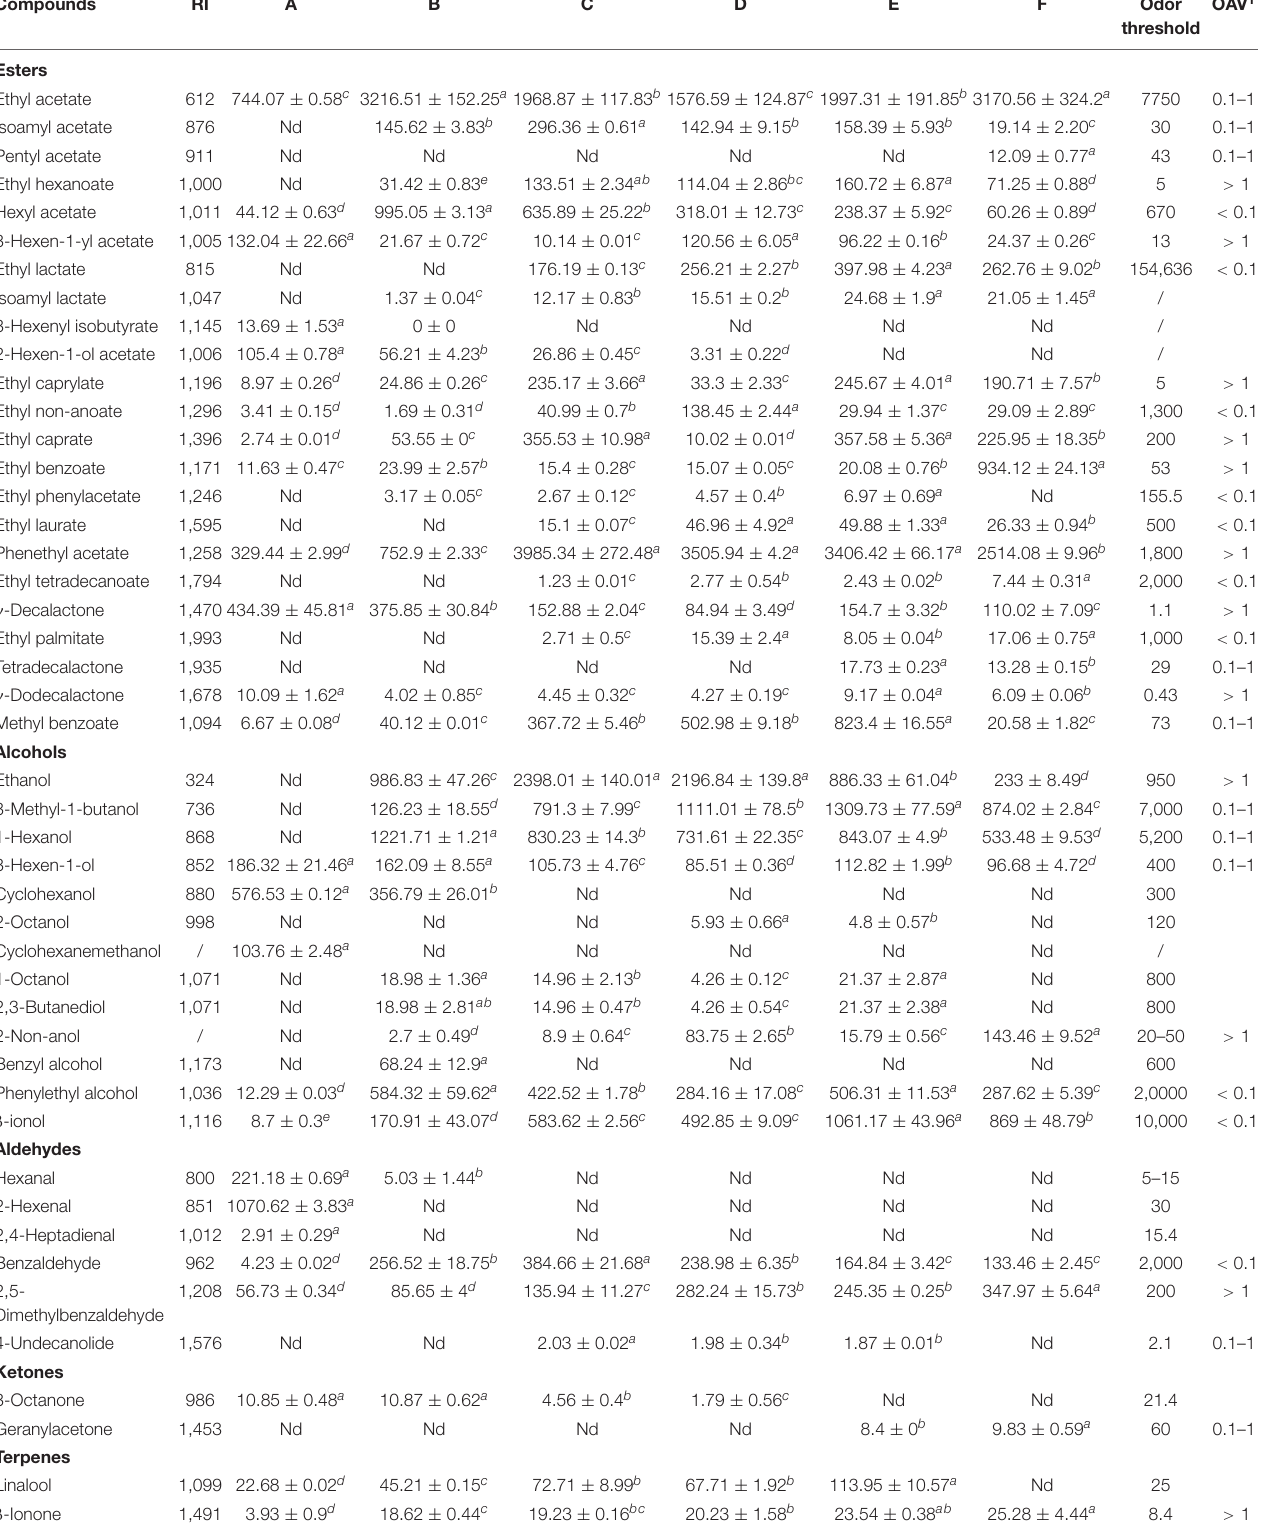
TABLE 1 | Dynamic changes in the content of flavor compounds during the fermentation process ( µ g/L). Compounds